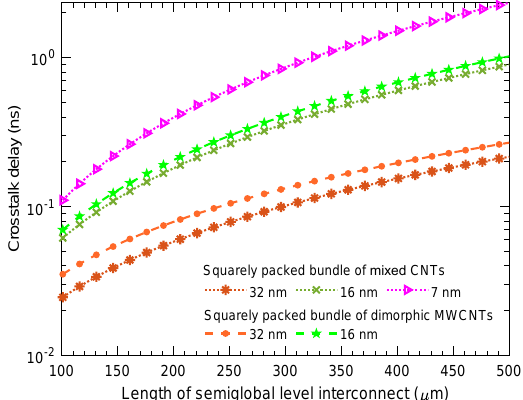
Figure 11. Comparative analysis of the crosstalk delay of the proposed and previously developed bundle configurations for different technology nodes at semiglobal-level interconnect lengths. The dimension of the used CNTs are the same as those used in the simulation for obtaining propagation delays at the semiglobal level.